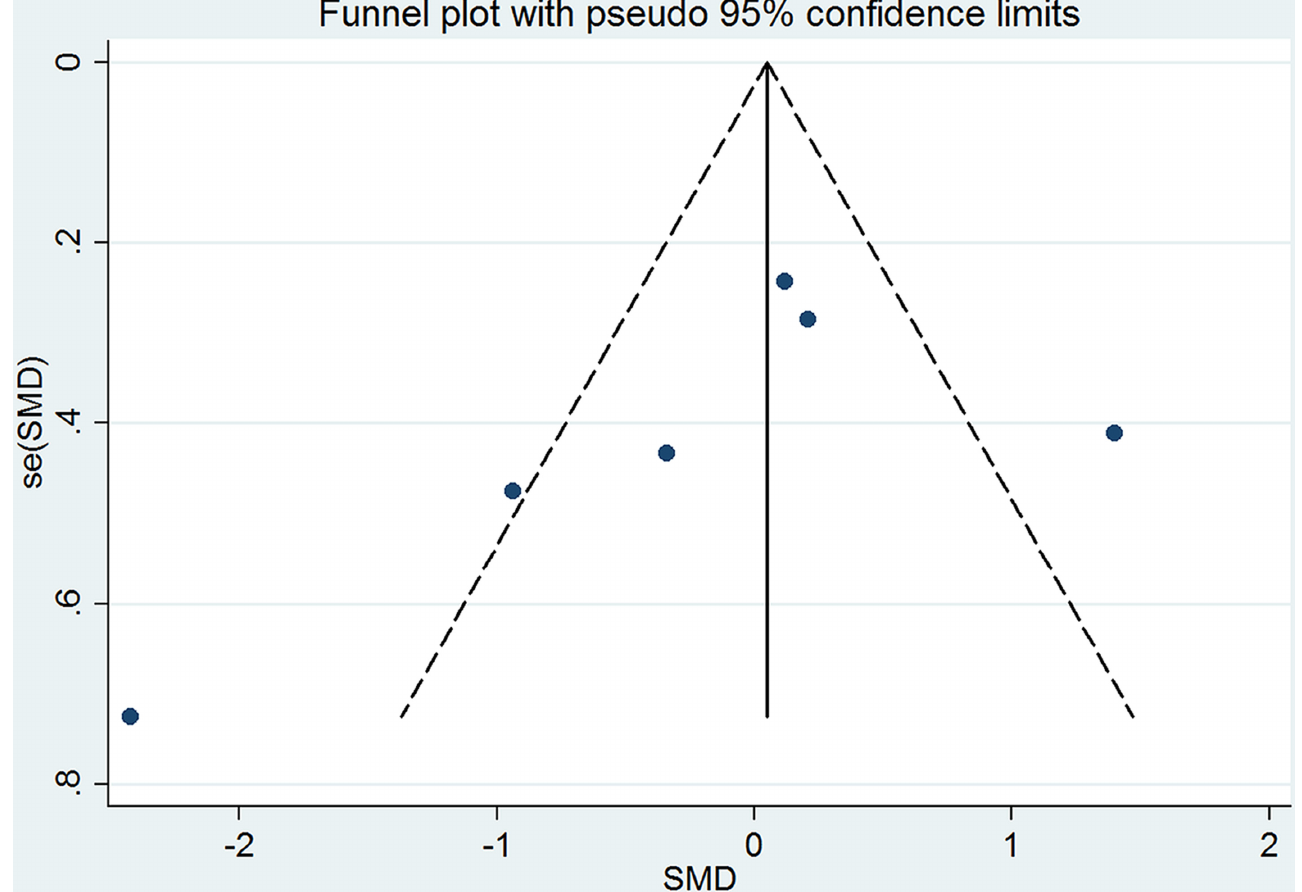
Fig 3. Funnel Plot of Included